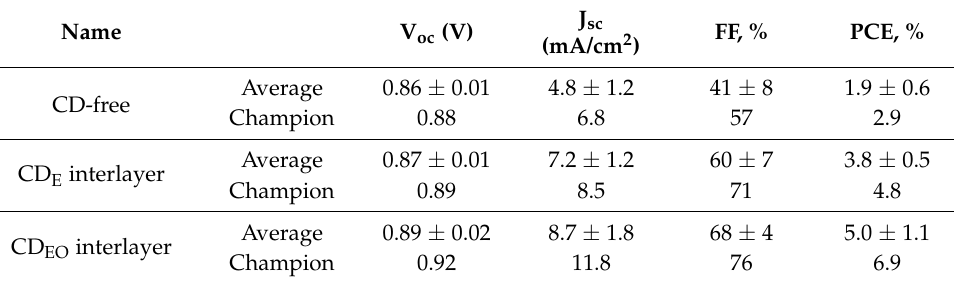
Figure 6. ( a ) J sc , ( b ) V oc , and ( c ) FF of control (blue) perovskite-base photovoltaic devices and the devices with CD E (orange) and CD EO (green) interlayers. Table 2. Photovoltaic parameters (average and champion devices) of control devices, and the devices with CD E and CD EO interlayers.